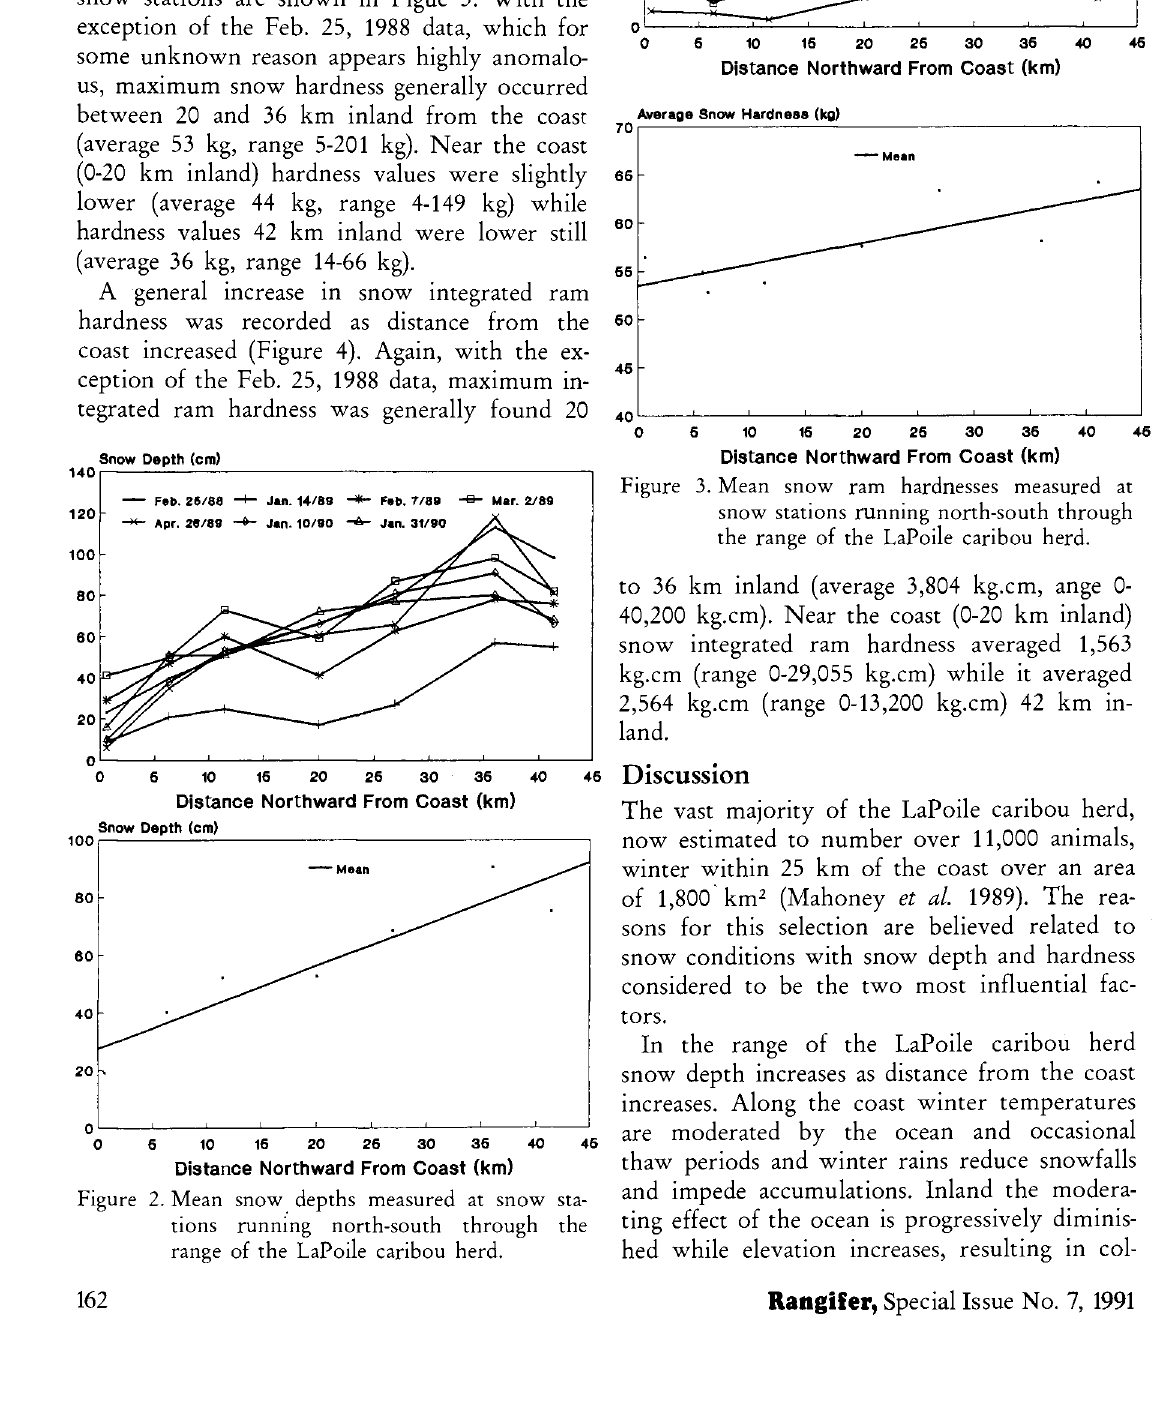
Figure 2. Mean snow depths measured at snow sta tions running north-south through the range of the LaPoile caribou herd.